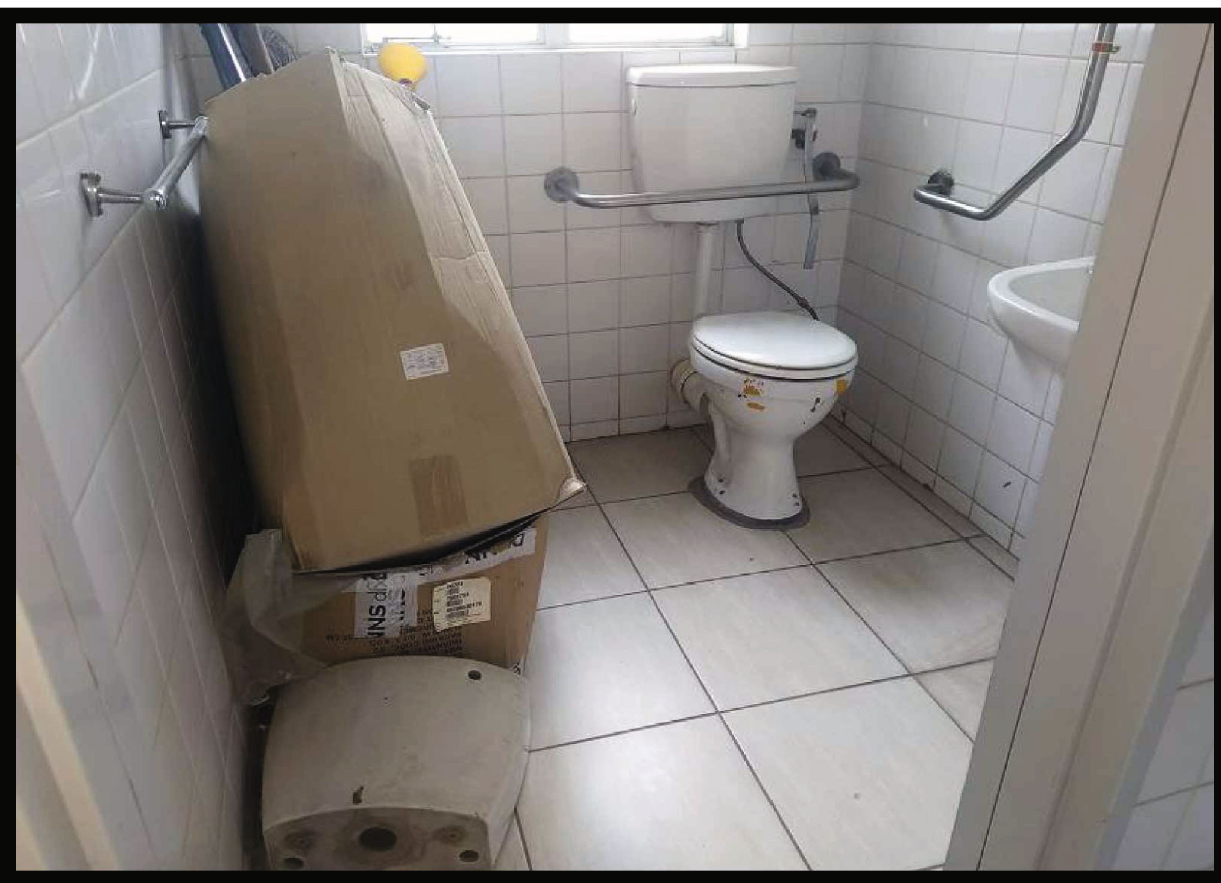
Figure 5: A toilet for wheelchair users used as a storage